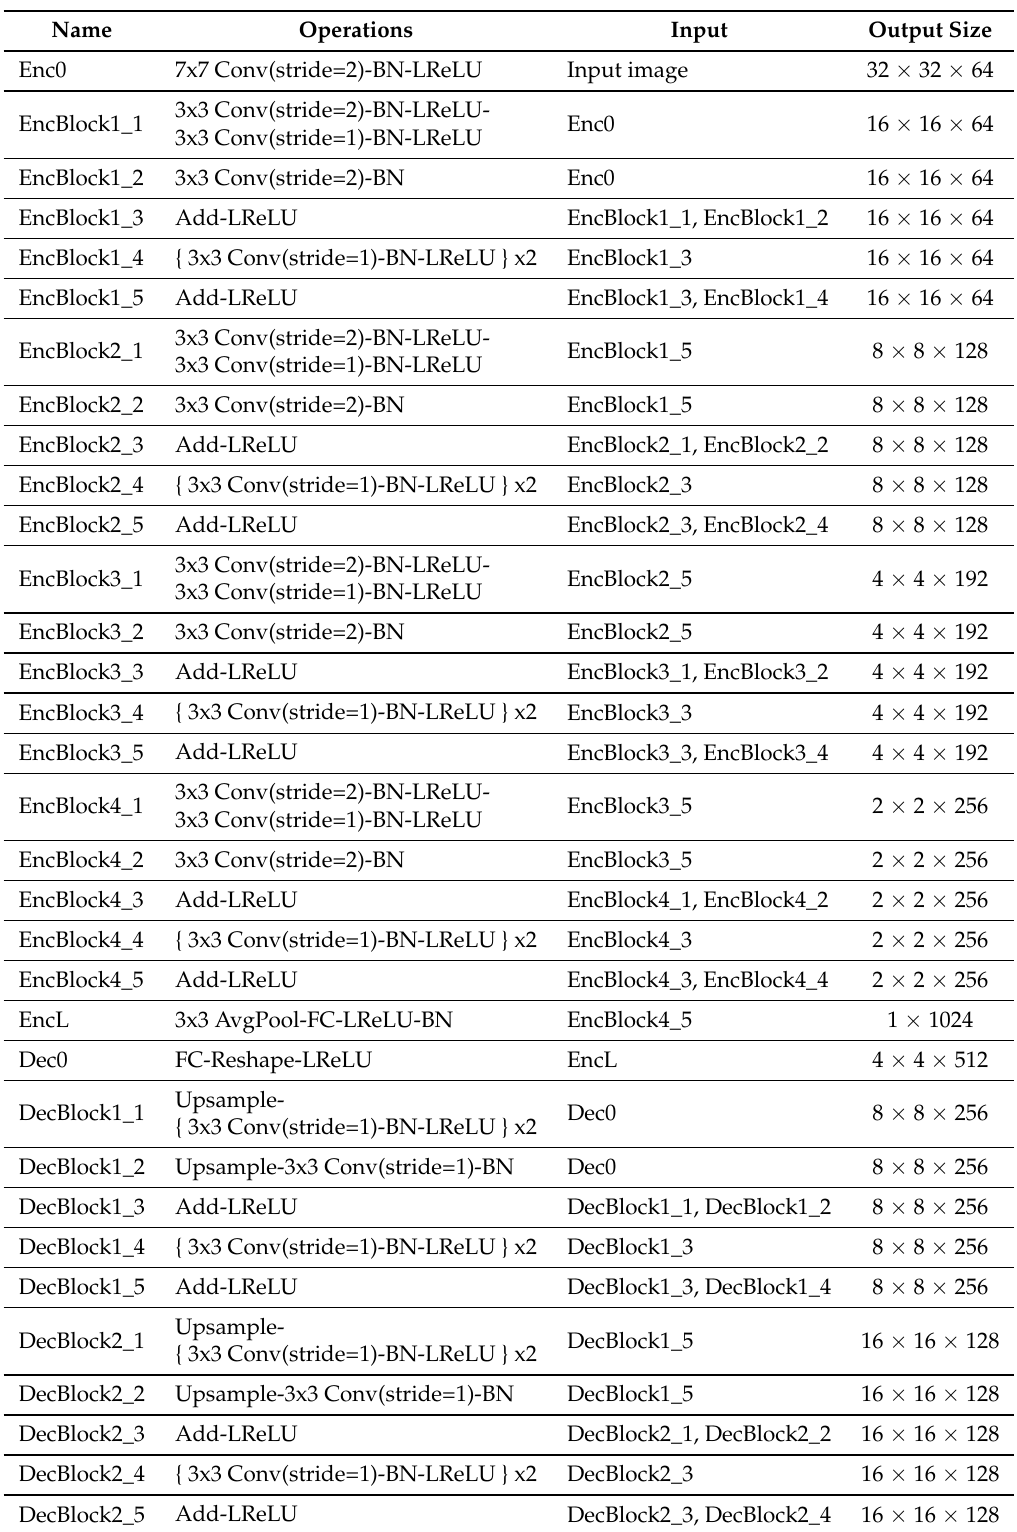
Table 1. Architecture of the proposed network. Where LReLU is leaky ReLU, BN is batch normalization, FC is fully connected layer, ’3x3 Conv’ is a convolution of which filter size is 3 by 3, and, ’3x3 AvgPool’ is an average pooling of which filter size is 3 by